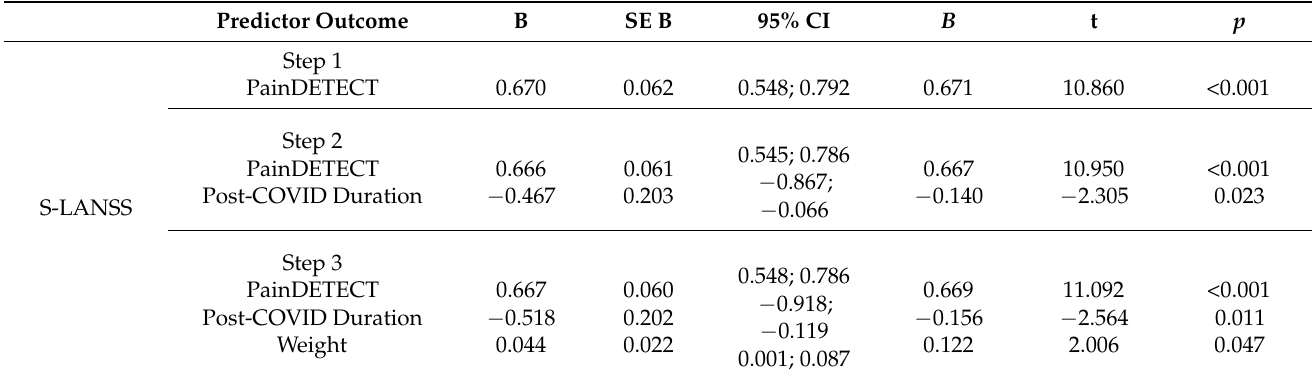
Table 3. Stepwise regression analyses to determine predictors of self-reported version of the Leeds Assessment of Neuropathic Symptoms and Signs (S-LANSS) score.